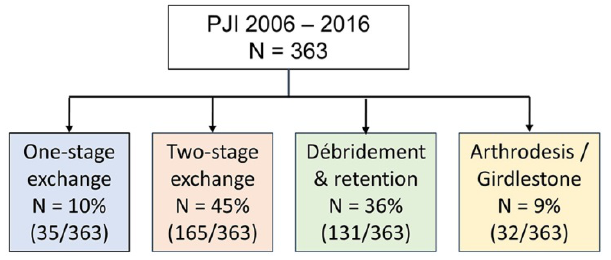
Figure 1. Flow of the patient selection.